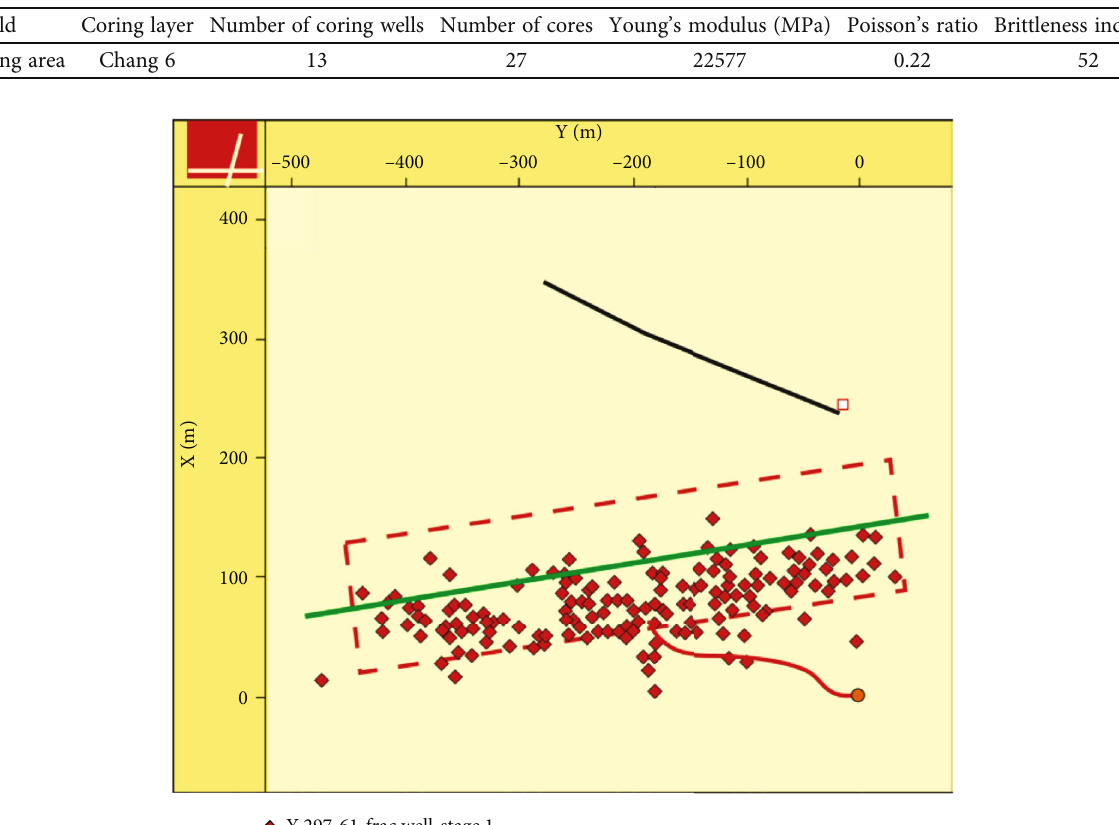
Table 2: Mechanical parameters of sandstone in typical blocks of Ordos Basin.